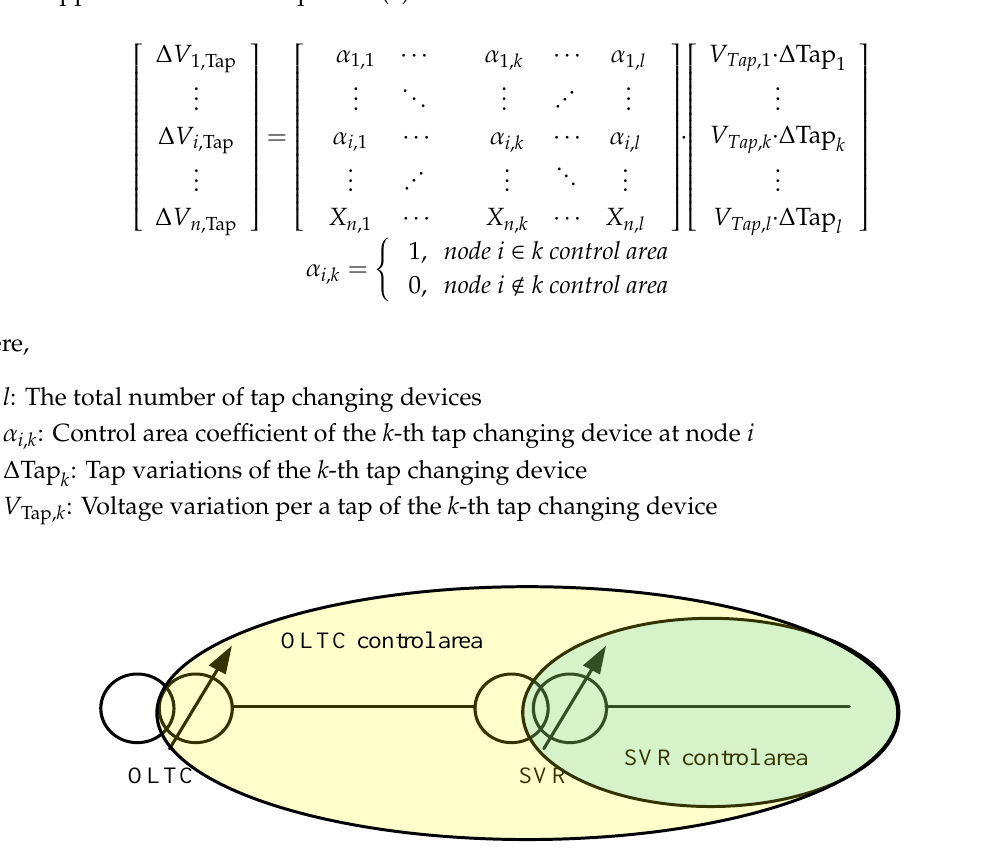
Figure 2. Control area of tap changing devices.